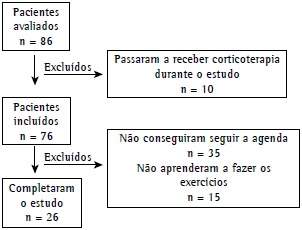
Fluxograma do estudo.